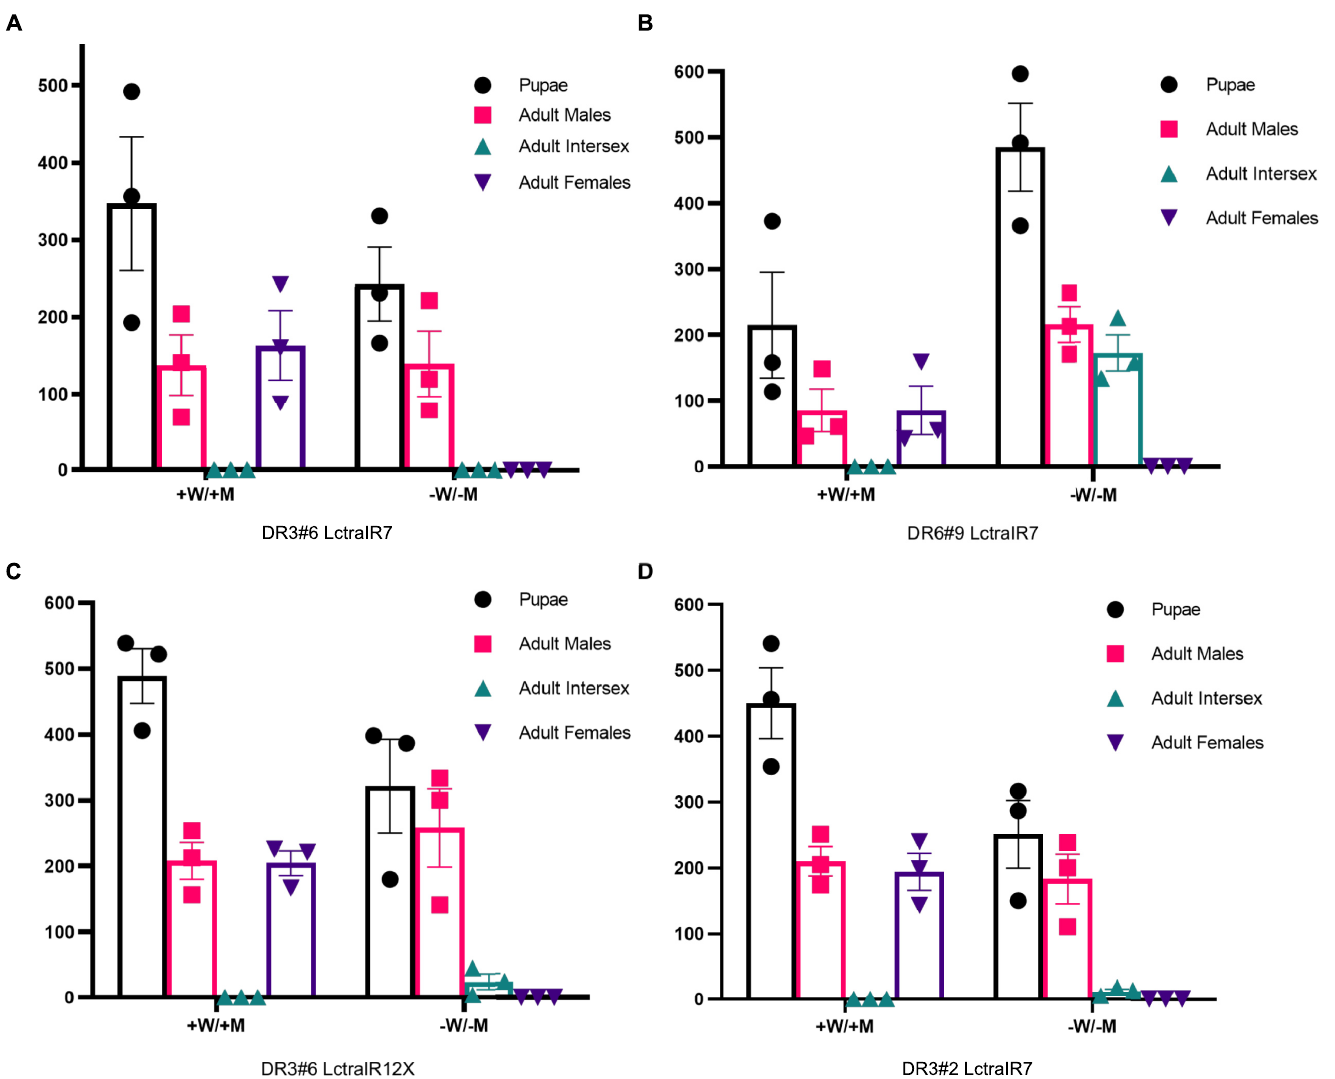
Fig 2. Conditional knockdown of Lctra leads to masculinization of double homozygous XX flies. (A-D) Female to male transformation of double homozygous lines DR3#6; LctraIR7 (A), DR6#9; LctraIR7 (B), DR3#6; LctraIR12X (C) and DR3#2; LctraIR7 (D) with (+W/+M) or without (-W/-M) tetracycline added to the maternal and larval diets. The flies were scored as male, female or intersex based on external morphology. Three biological replicates are shown with mean and standard error.